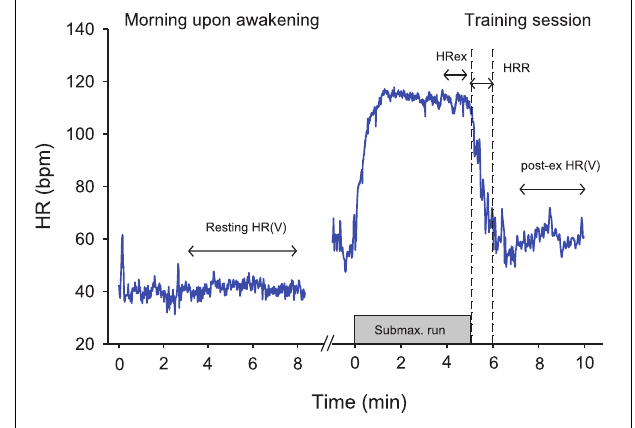
FIGURE 2 | Example of the different heart rate (HR) recording conditions during the day time. HRex, exercise HR; HRR, HR recovery over 60s; HRV, HR